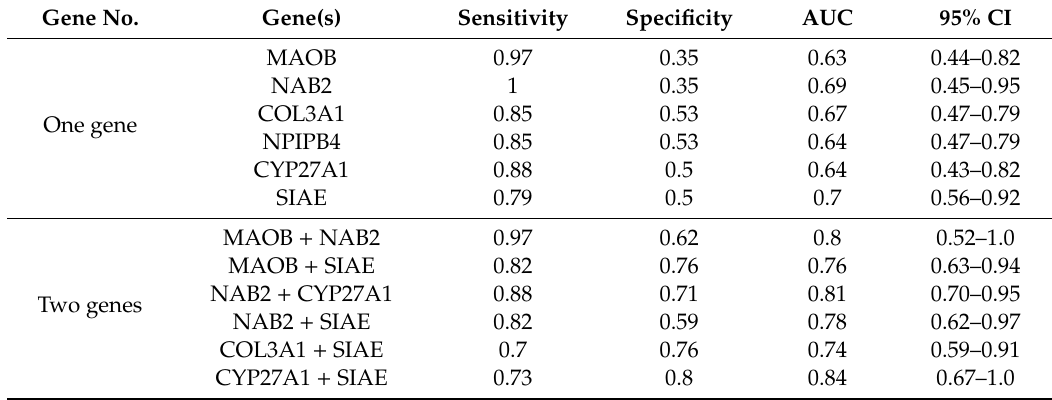
Table 3. Sensitivities, specificities, and area under the curve (AUC) values for OSCC samples vs. non-tumor controls.